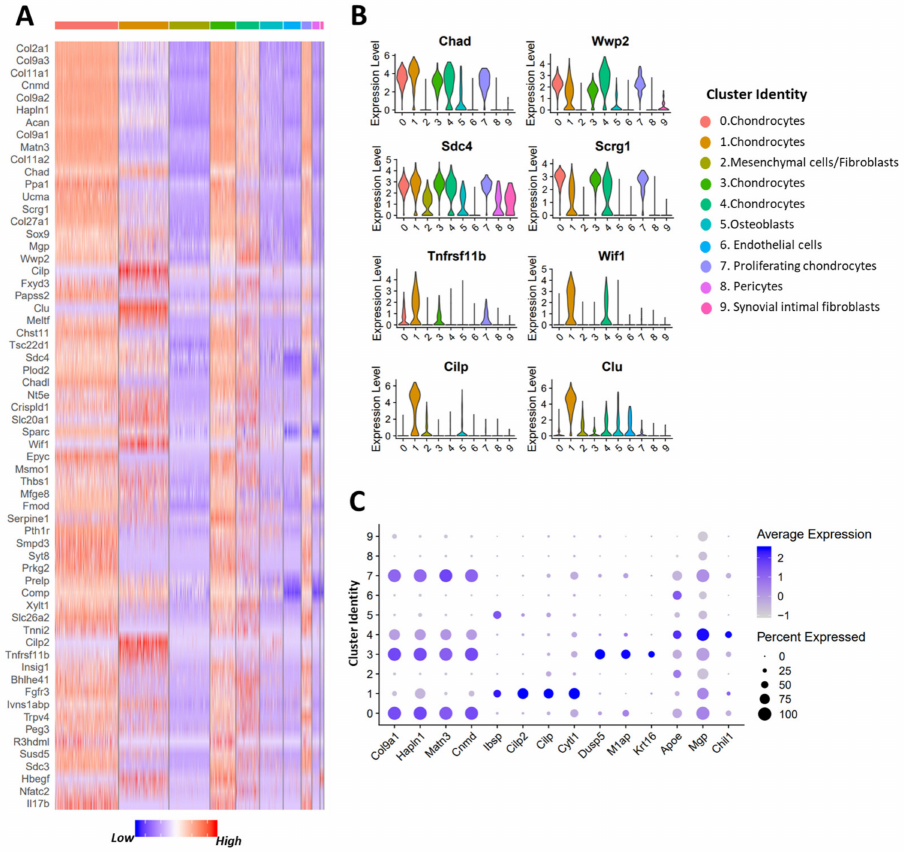
Figure 2. Identification of potential OA targets enriched in chondrocytes. ( A ) Heatmap showing potential OA targets enriched in chondrocyte clusters compared to other connective-tissue forming cell types in the joint. ( B ) Violin plot showing the expression of selected OA targets that are expressed in all chondrocyte subtypes and OA targets with a restricted expression pattern. ( C ) Dot plot showing the expression of selected markers of various chondrocyte clusters. Dot size represents the fraction of cells expressing a specific marker and color intensity indicates the average expression level in that